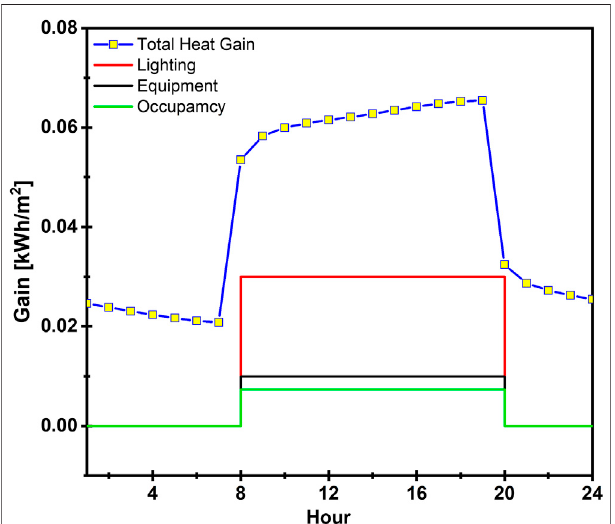
FIGURE 5 | The variations in the various heat transfer mechanism.